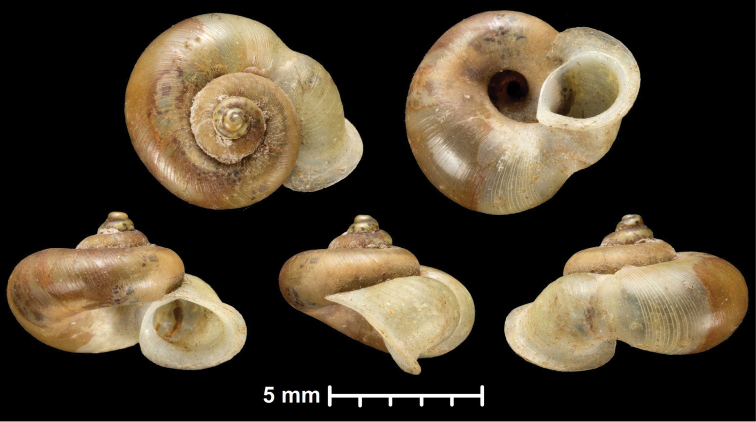
Stomacosmethis
kuekenthali (P. Sarasin & F. Sarasin, 1899) (NHMUK 20160313). Photographs: Harold Taylor (NHM).